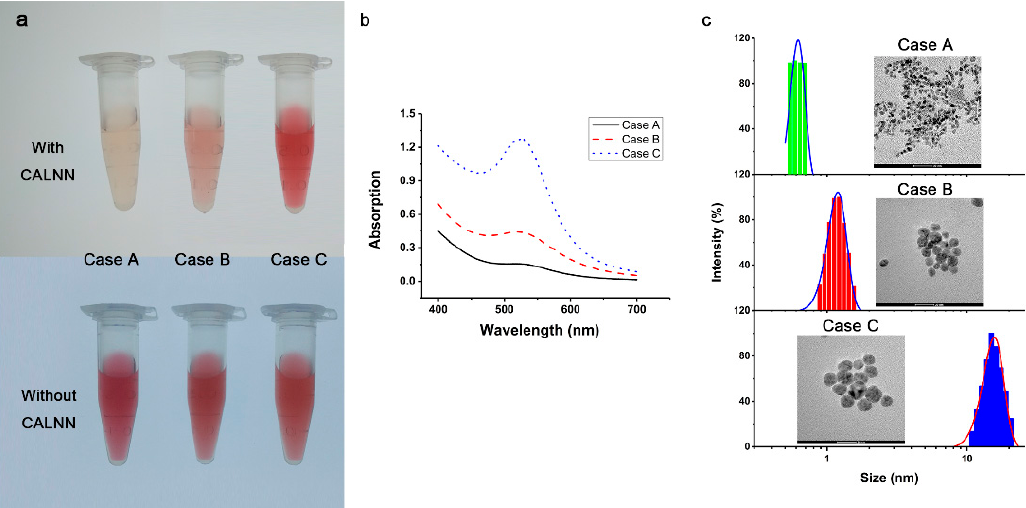
Figure 1. ( a ) Photographs of the products obtained by different preparation procedures (upper) with and (lower) without CALNN. ( b ) UV–vis absorption spectra corresponding to the products with CALNN. ( c ) TEM and DLS analysis of the size of AuNPs in different routes. Method A: AuCl 4- was adding to the mixture of tyrosine and CALNN; Method B: AuCl 4 ‒ and tyrosine was mixed firstly and followed by CALNN; Method C: tyrosine was adding to the mixed solution of AuCl 4 ‒ and CALNN.